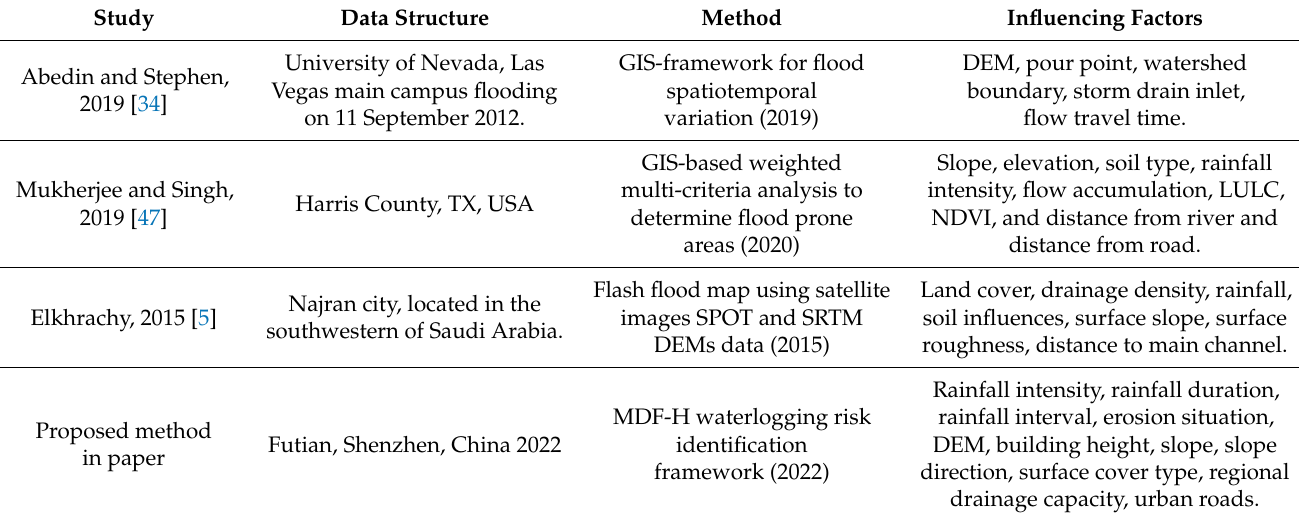
Table 9. Comparison of results with other